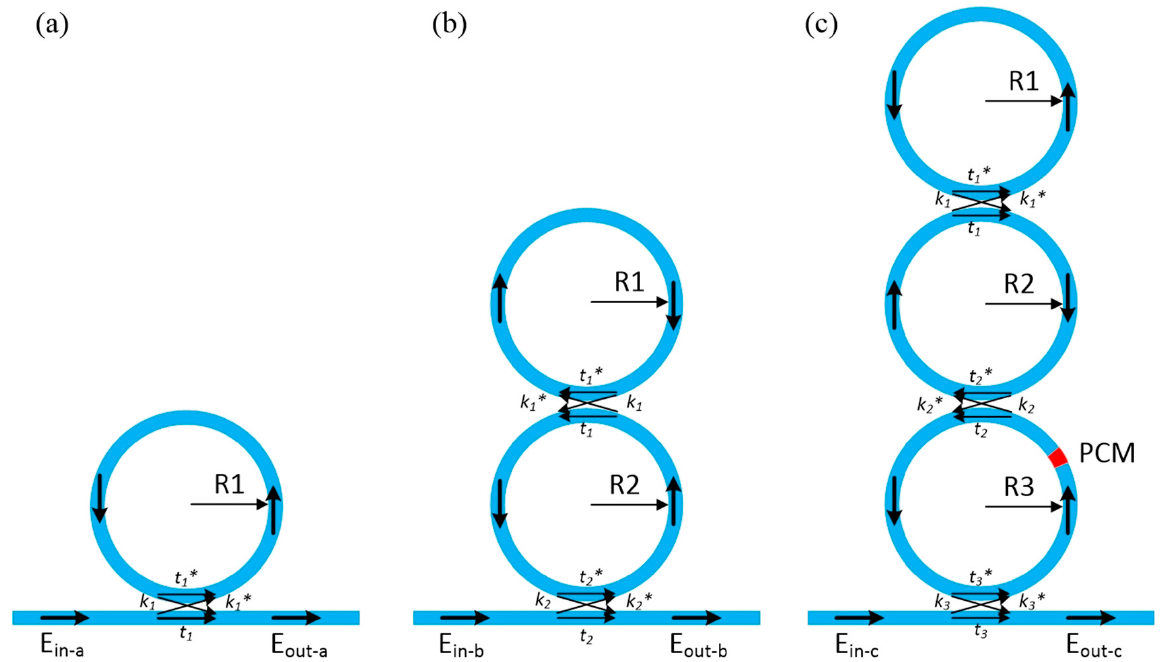
Figure 2. Coupling of micro-ring array with straight waveguide: ( a ) Coupling of a single micro-ring with a straight waveguide; ( b ) Coupling of double micro-rings in series with straight waveguide; ( c ) Coupling of three micro-rings in series with straight waveguide.